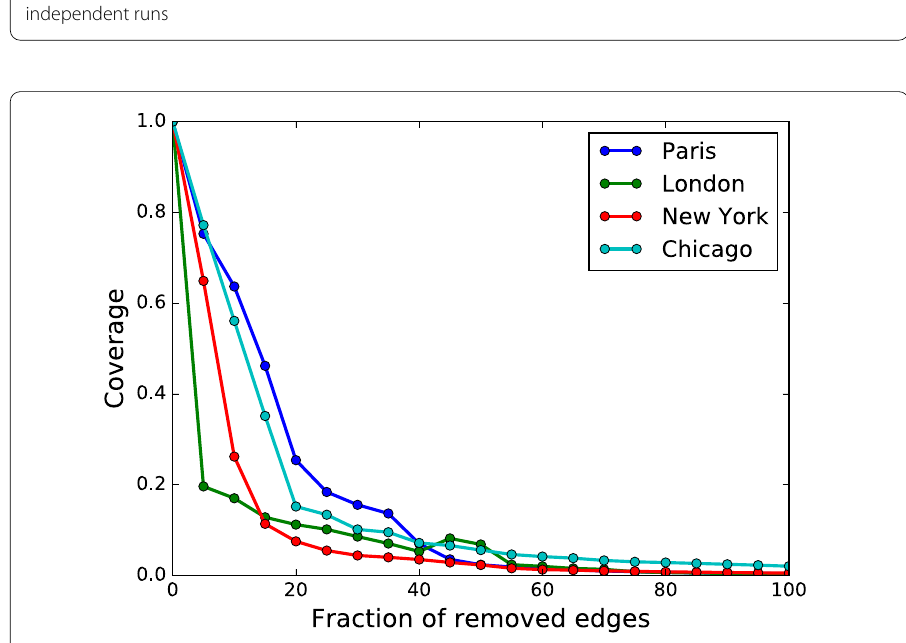
Figure 7 Robustness to failure of three big cities: Paris, London, and New York